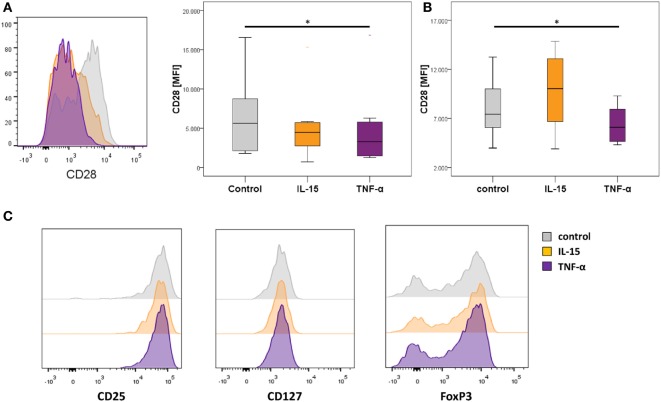
In vitro downregulation of CD28 in regulatory T-cells (Tregs) in the presence of TNF-α. Graphs show (A) representative histograms showing CD28 expression of control Tregs (gray), following IL-15 stimulation (orange), and following TNF-α stimulation (violet), and box plots show median expression of CD28 (MFI) in Tregs of eight healthy individuals after the first expansion phase, (B) the second expansion phase, respectively; and (C) representative histograms of CD25, CD127, and FoxP3 expression. Mann–Whitney U test was used to assess differences between groups. *p < 0.05.